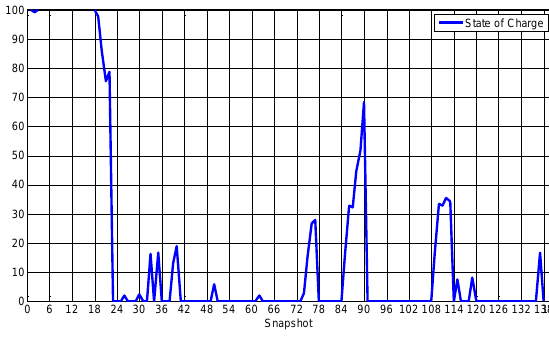
Fig.10 . State of charge (140